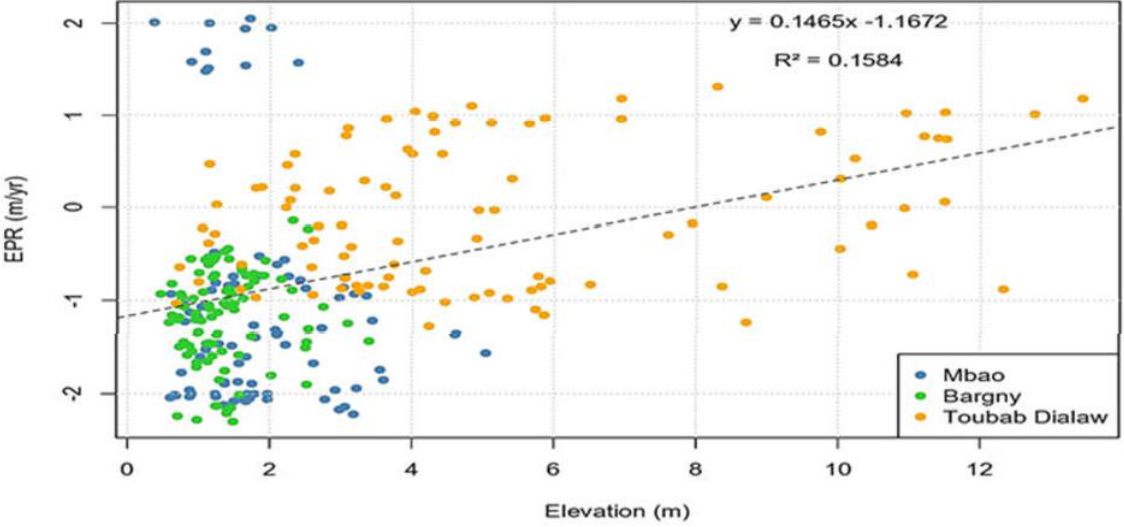
Figure 9. Cross plot of the shoreline change rate (EPR) and topography in the three littoral cells. The coefficient of correlation between the coastline dynamic and slope is estimated at 0.56 in Mbao and 0.87 in Bargny, whereas in the littoral cell of Toubab Dialaw, the coefficient is lower than those recorded in Mbao and Bargny (0.06) because of high slope values with an average of about 17.92 ◦ and a low dynamic rate of − 0.06 m/year (Figure 10). The following figure is the box plot of the topography, slope and coastline dynamic rate (EPR) in the three littoral cells. It helps to understand the distributional characteristics of the topography, slope and coastline dynamic value in each littoral cell. For the topo- graphy, the upper quartiles in Mbao and Bargny are lower than 2.5 m, whereas in Toubab Dialaw, 50% of the observed values exceed 4 m. In terms of slope, all quartiles are lower than 10.5 ◦ . In Toubab Dialaw, 75% of observations are higher than 10 ◦ . In Mbao and Bargny, 75% of quartiles regarding the coastline dynamic rate are lower than 0.8 m/year, whereas, in Toubab Dialaw, 75% of quartiles are higher than 0.8 m/year (Figure